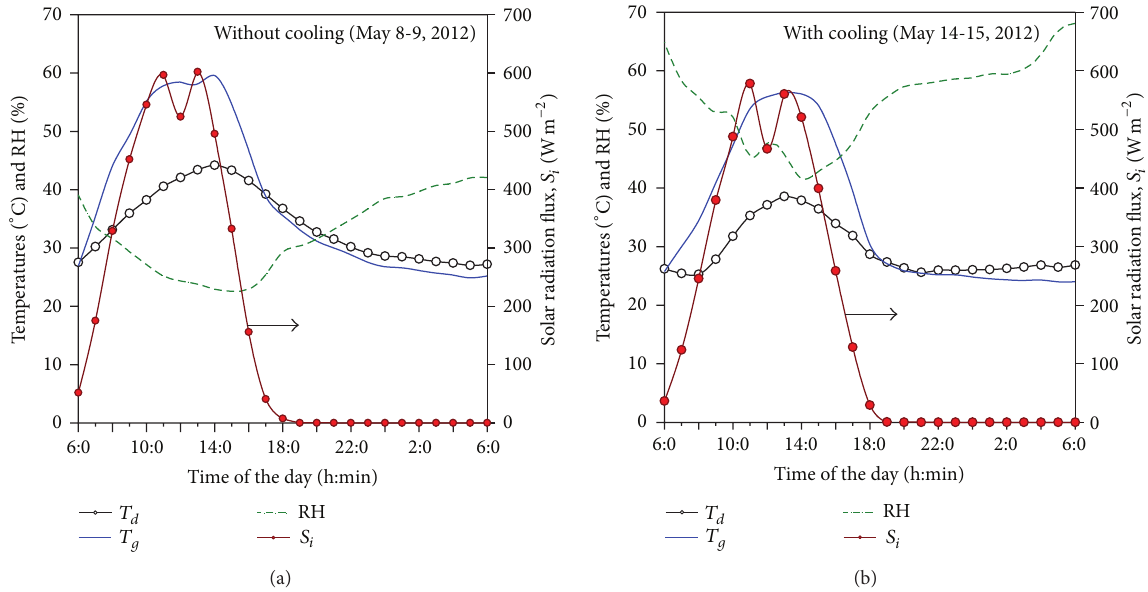
Figure 2: Time course of the dry bulb temperature ( 𝑇 𝑑 ), relative humidity (RH), and solar radiation flux ( 𝑆 𝑖 ) measured in the greenhouse: (a) without cooling and (b) with cooling of the inside